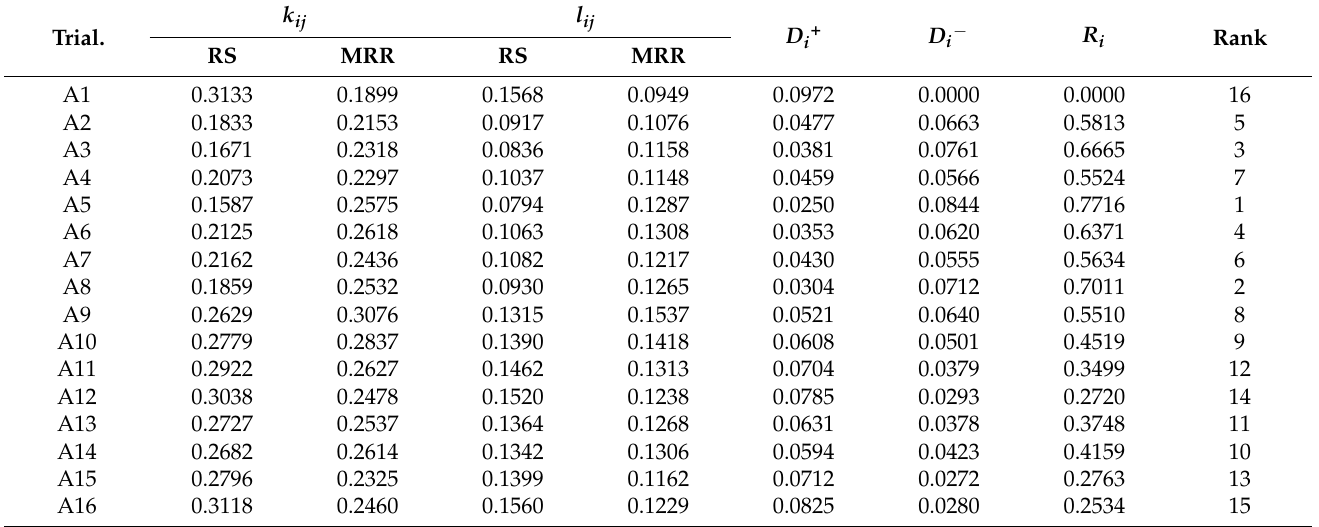
Table 5. Calculated parameters and ranking by the TOPSIS